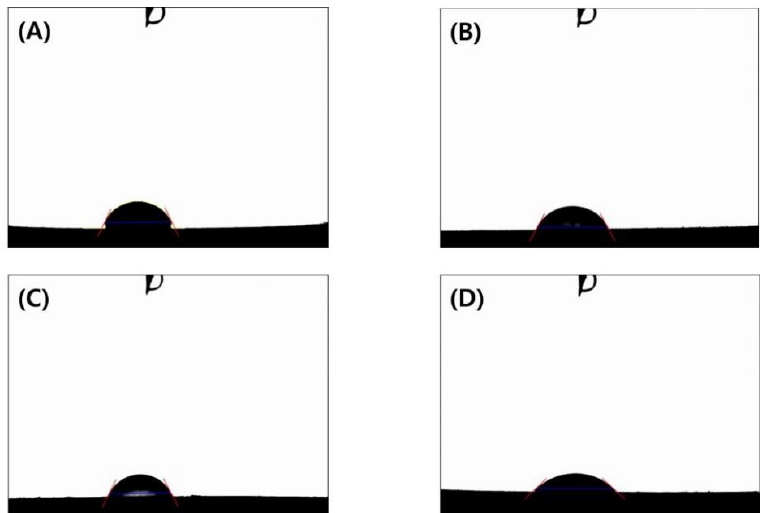
Figure 3. Contact angle of the water droplet on the surface. ( A ) IAP-D group; ( B ) IAP-1 group; ( C ) IAP-10 group; ( D ) TPM-10 group.